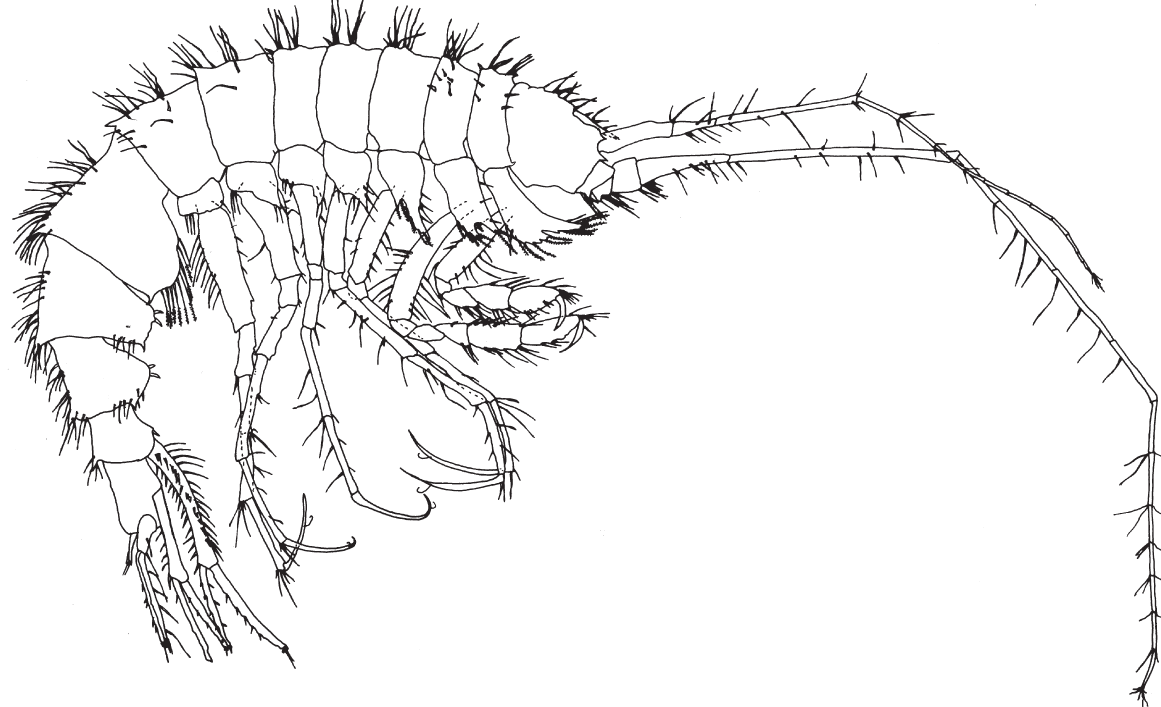
Fig . 4. – Lepechinella hirsuta n. sp., holotype, female, 5.5 mm, MnrJ20523, oceanprof i #60, 21°52’50.5’’S to